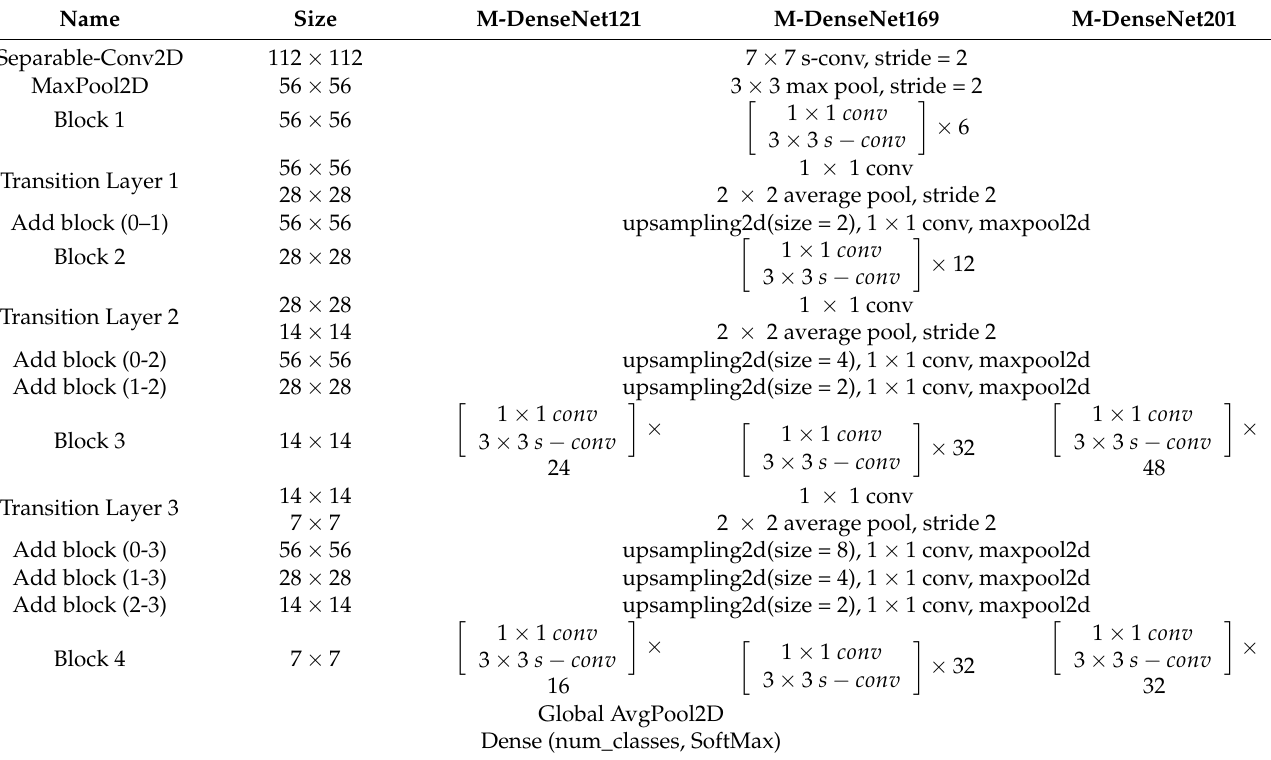
Table 1. MDenseNet’s architectures.